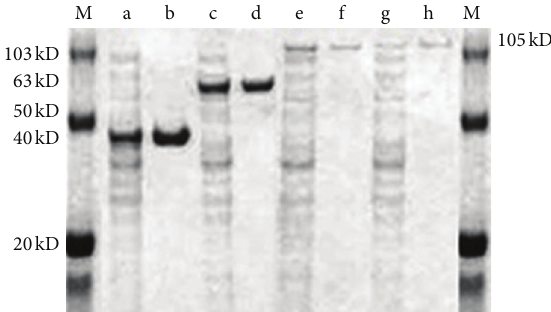
Figure5:SDS/PAGEofrecombinantenzymesproducedindifferent yeast strains. Lane M: molecular mass standards; lane a, crude extractFPPS;laneb:purifiedFPPS;lanec:crudeextractADS;laned: purified ADS; lane e: crude extract FPPS-ADS; lane f: purified FPPS- ADS lane g: crude extract ADS-FPPS; lane h: purified ADS-FPPS. The calculated molecular weights of FPPS, ADS, and the fusion enzymes were 40, 63, and 103 kDa,